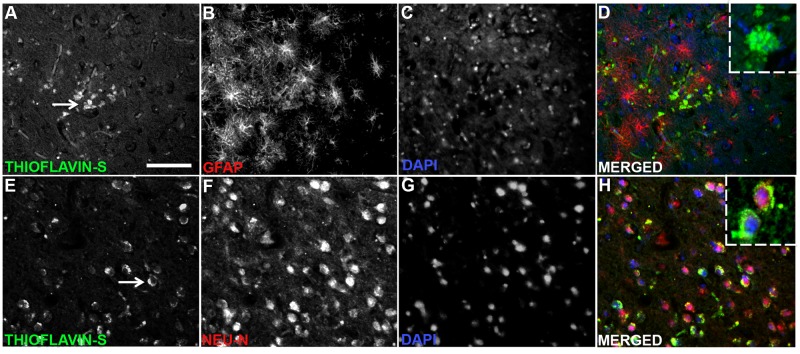
Thioflavin-S+ pathology in the auditory cortex of stranded dolphins.Thioflavin-S+ staining and IHC with GFAP and Neu-N was used to determine co-localization of plaques and intracellular inclusions with astroglia and neurons in the stranded dolphin brain. (A, E) Thioflavin-S+ plaques and intracellular staining was observed in the ACtx (arrows). (B, F) Activated GFAP+ astrocytes are demonstrated surrounding a cluster of dense thioflavin-S+ plaques. Neu-N+ neurons are shown with intracellular thioflavin-S+ inclusions. (C, G) DAPI staining highlights intact cellular nuclei. (D, H) The merged panels show the relative co-localization of thioflavin-S+ plaques, blood vessels, and intracellular inclusions within astrocytes and neurons. Panel inserts (dotted lined boxes) show high magnification detailing thioflavin-S+ structures. Representative scale bar: 150 μm.